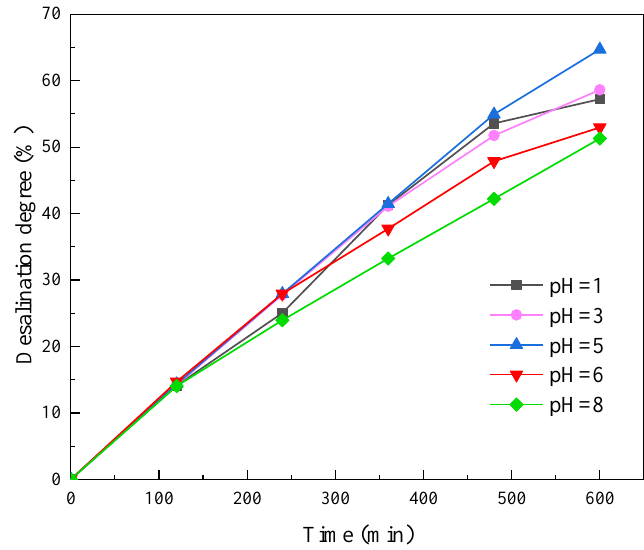
Figure 4. Desalination degree under different pH values.